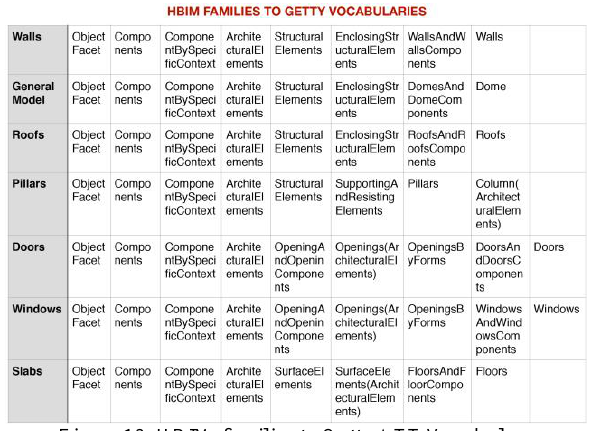
Figure 13. HBIM families to Getty ATT